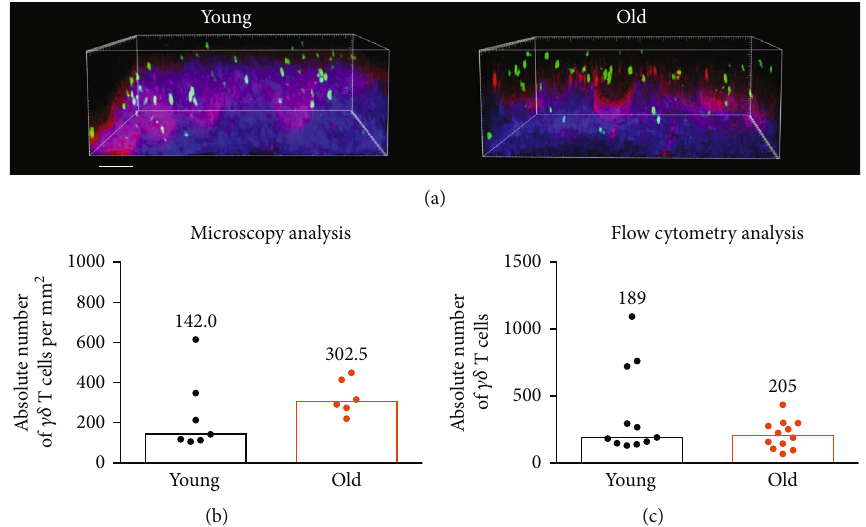
Figure 1: The analysis of vaginal γδ T cell numbers in young and old mice. (a) Microscopic visualization of γδ T cells in the vaginas of Tcrd- H2BeGFP mice. Side projections of vaginal wall with GFP-expressing γδ T cells. GFP shown in green, laminin 5 in red, and stromal collagen in blue. Scale bar = 50 μ m. (b, c) Quanti fi cation of γδ T cells in murine vagina in young and old mice using microscopy (b) and cytometry (c). Each spot represents an individual young (black, 2 months old) and old mouse (orange, 18 months old). N = 7 mice per group (microscopy); n = 12 mice per group (cytometry). Bars and numbers show medians. No statistically signi fi cant di ff erences between groups (Mann – Whitney U test).